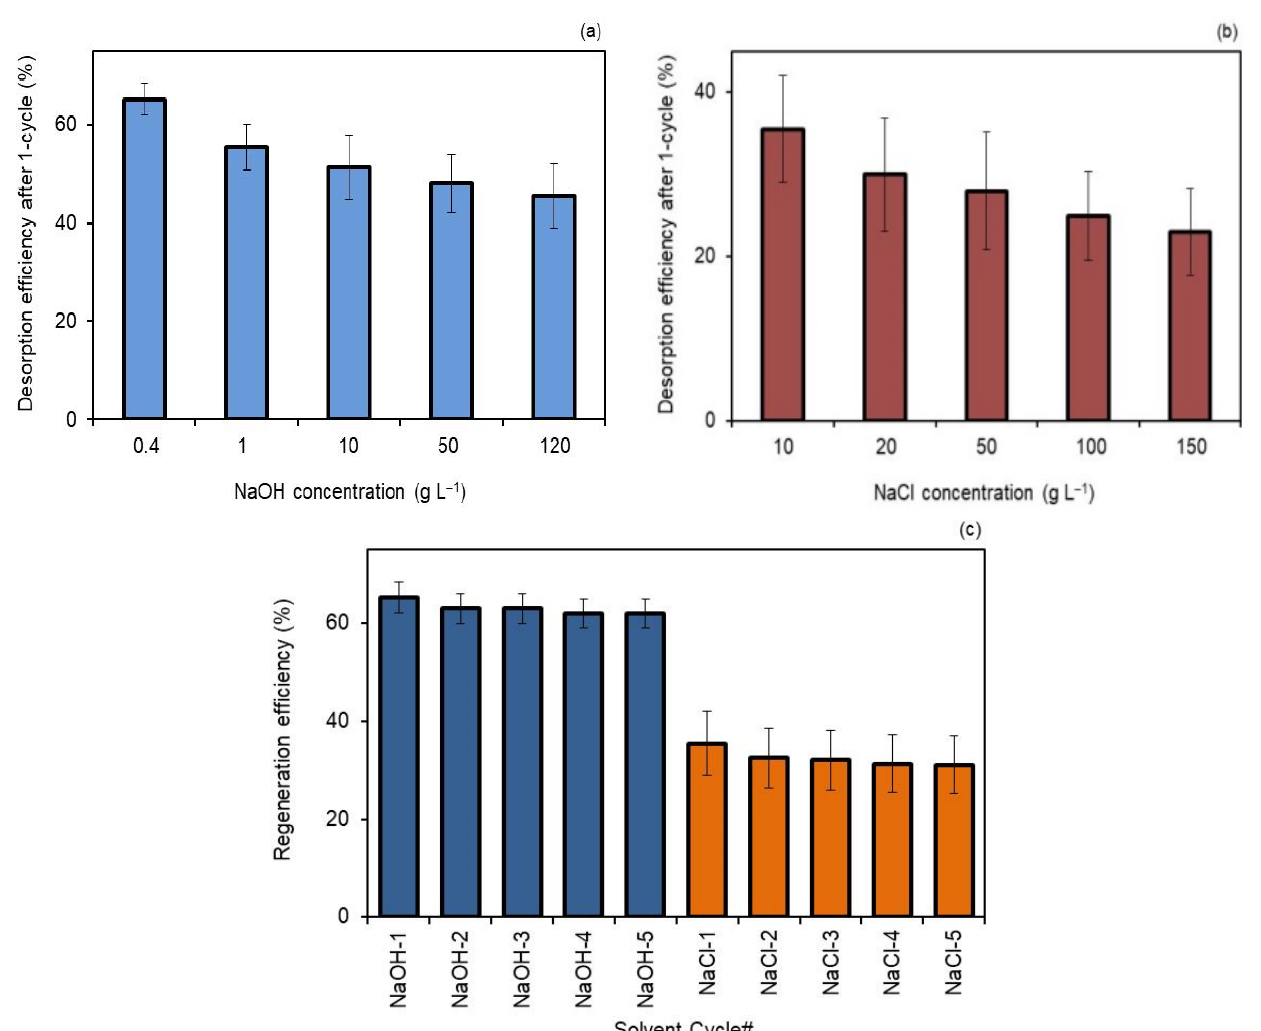
Figure 4. ( a ) Desorption behavior of M2 membrane with NaOH solutions after one cycle, ( b ) desorption behavior of M2 membrane with NaCl solutions after one cycle and ( c ) the recyclability of M2 for hydRB5 adsorption by regeneration using 0.4 g L − 1 NaOH and 10 g L − 1 NaCl.